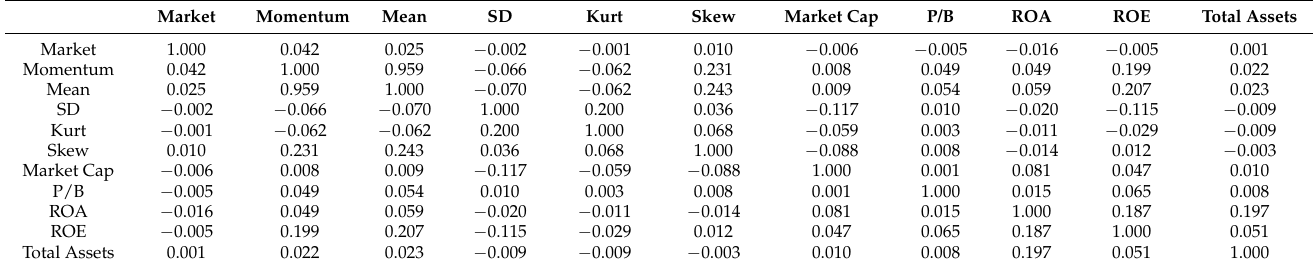
Table 2. Correlations among the